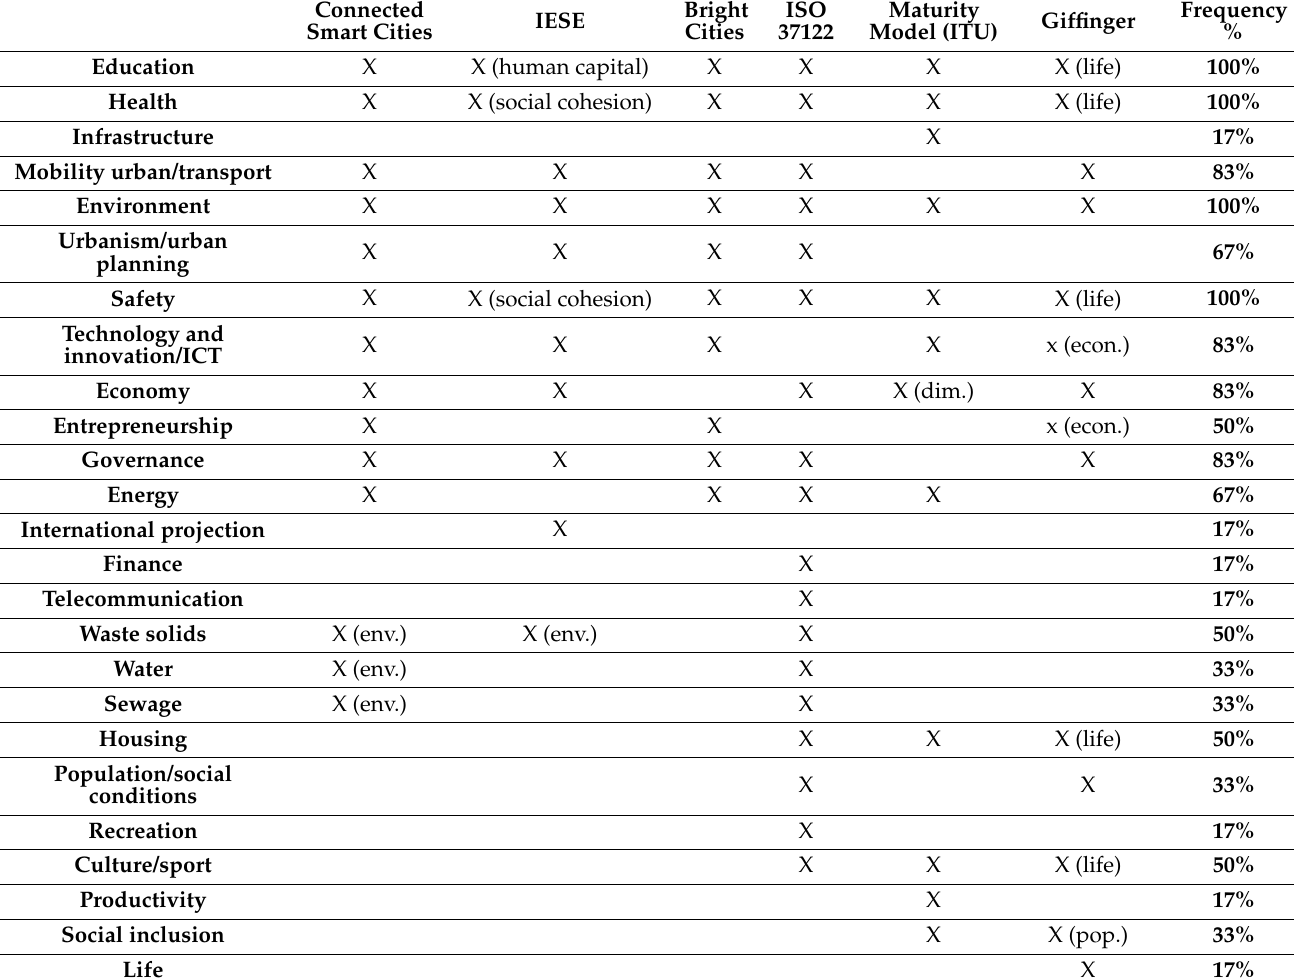
Table 3. Comparison of themes within the six groups of indicators analyzed.